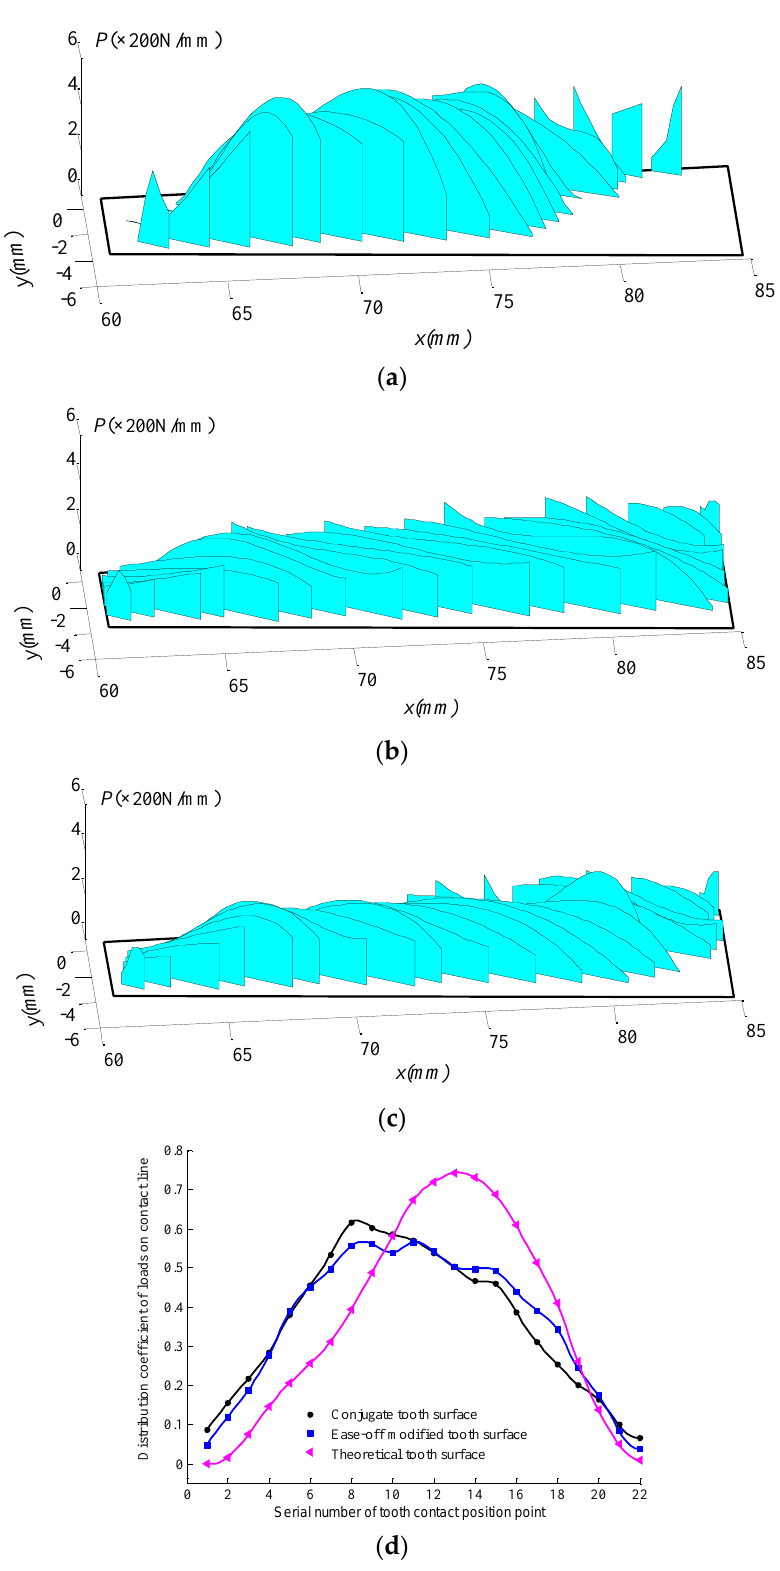
Figure 6. Tooth load distribution based on LTCA. ( a ) The load distribution for theoretical tooth. ( b ) The load distribution for the conjugate tooth surface. ( c ) The load distribution for the ease-off modification tooth surface. ( d ) Loads sharing a coefficient of the contact lines.